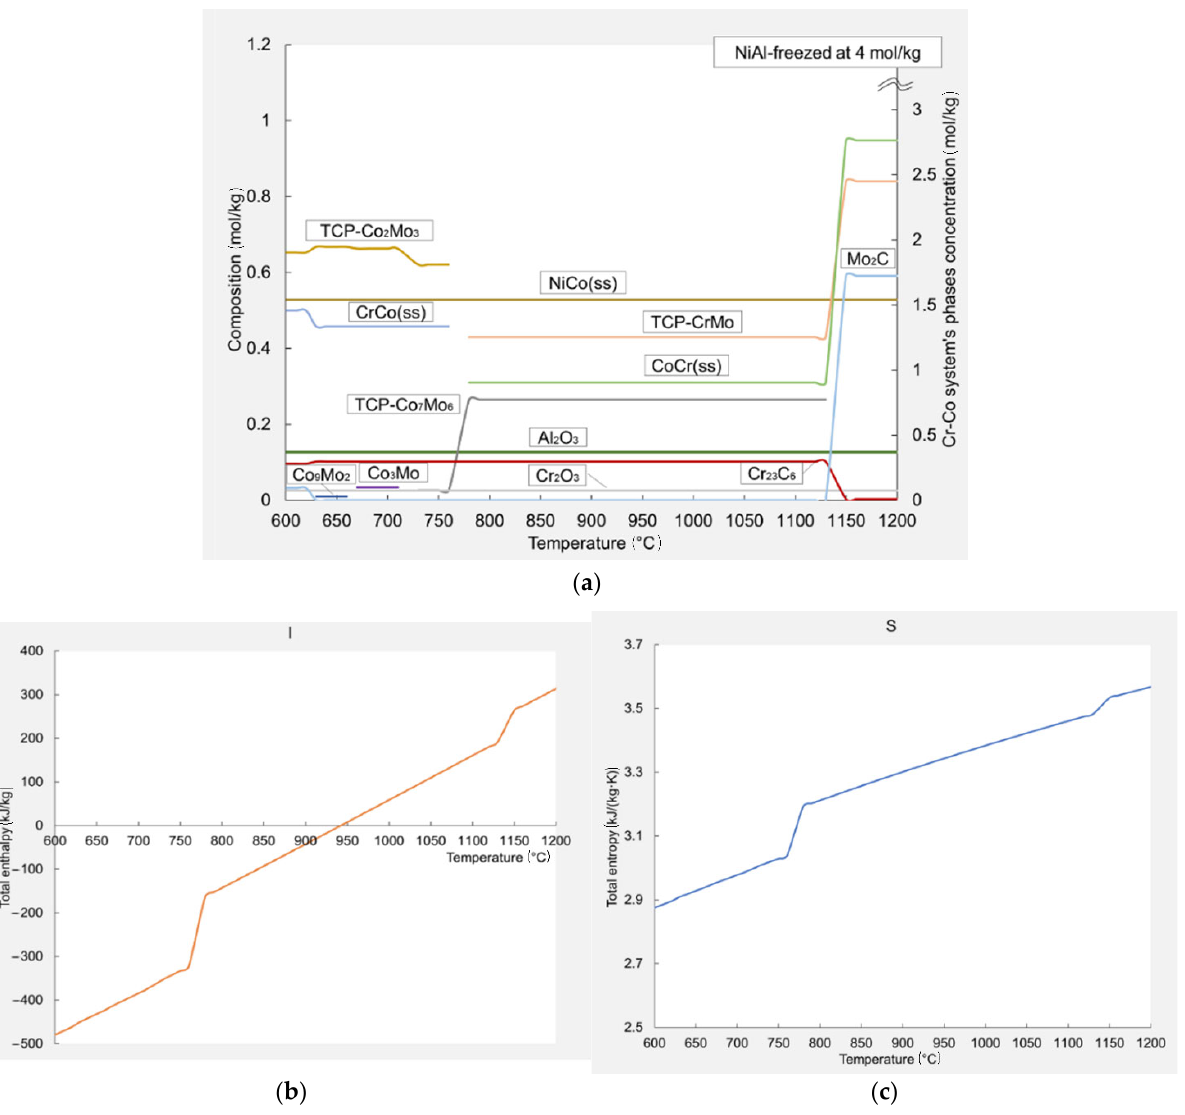
Figure 4. Thermodynamic modeling of the system equilibrium composition ( a ) and temperature dependences of the total enthalpy ( b ) and entropy ( c ) of the system.